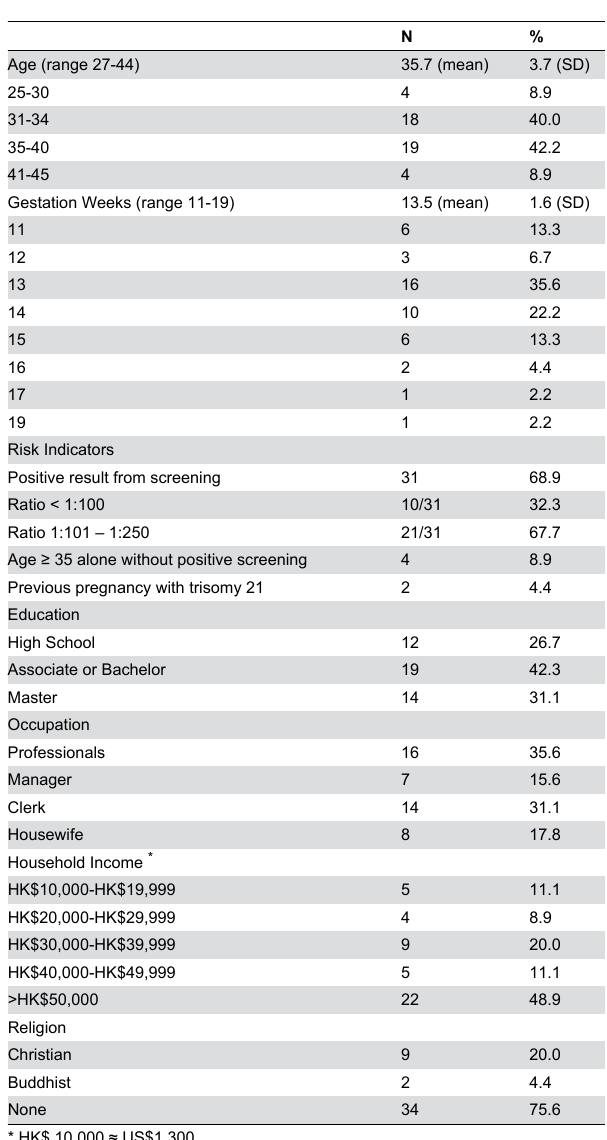
Table 1. Characteristics of interviewees